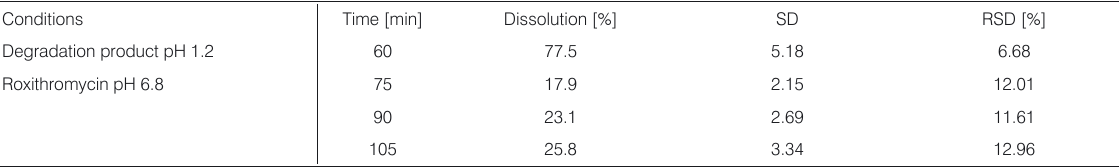
Table 2. Dissolution of roxithromycin and its degradation product from tablets for oral suspension at pH 1.2-6.8 (acid stage-buffer